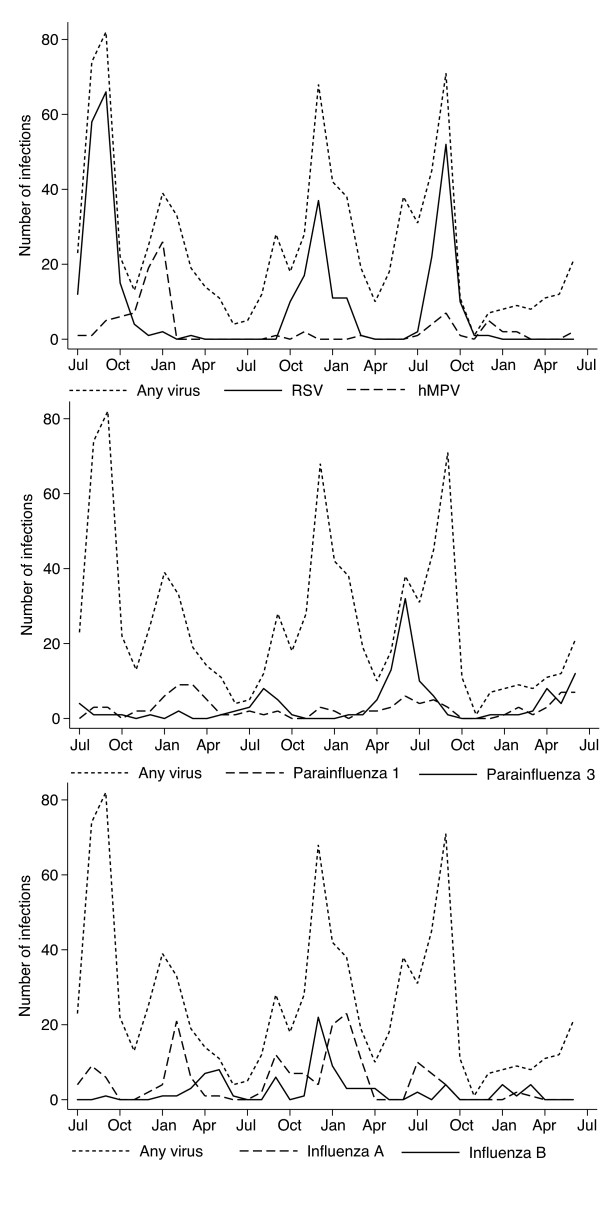
Monthly number of viral isolates in nasopharyngeal specimens from 2,219 cases with community-acquired pneumonia in children 2 to 35 months of age identified at a field clinic in Bhaktapur, Nepal, from July 2004 to June 2007. Parainfluenza 2 isolates were not included in the graph due to few positive cases.